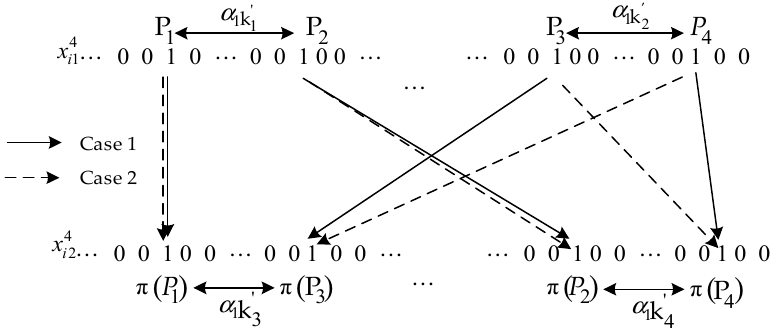
Figure 3. Weight-4 information sequence is mapped to weight-4 information sequence with similar pattern after permuted through interleaver.